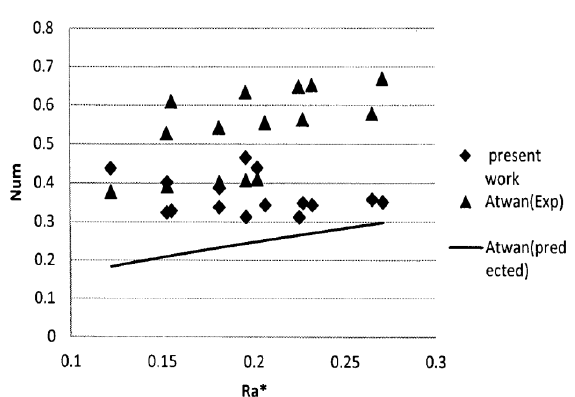
Figure 18.Comparison between the present work and the results of Atwan et al. [20].